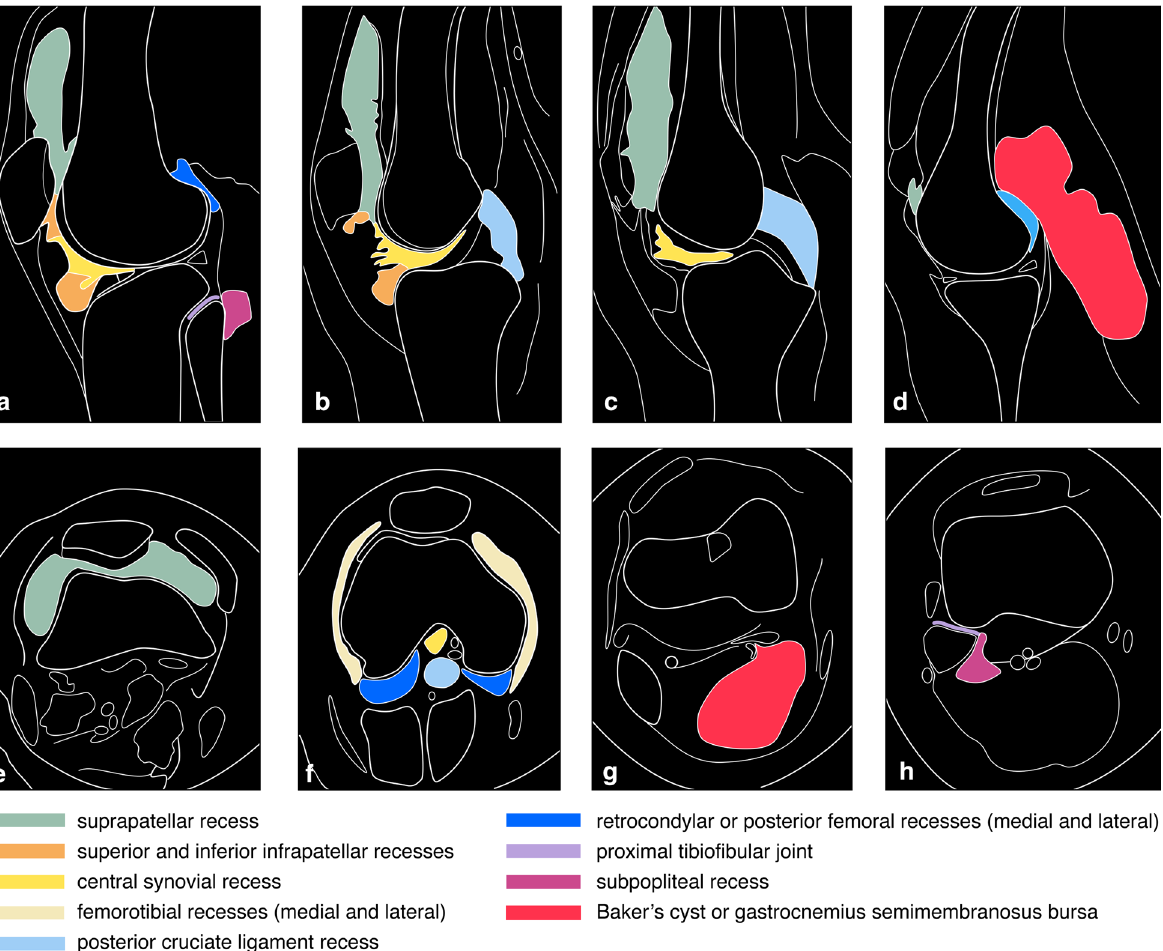
Fig. 1 Schematic overview of synovial recesses in the knee. a – d Sagittal drawings from lateral ( a ) to medial ( d ). e – h axial drawings from superior ( e ) to inferior ( h